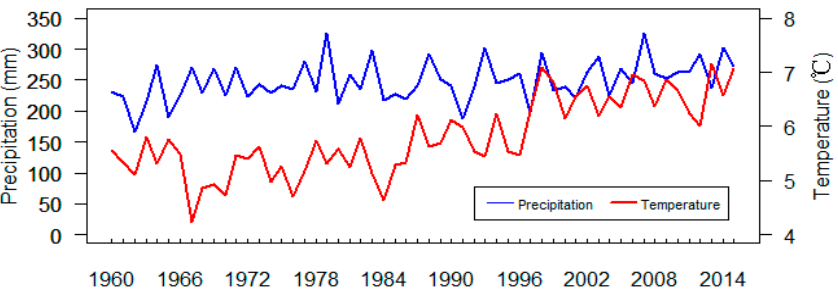
Figure 2. Annual mean precipitation and temperature over the study area from 1960 to 2015.